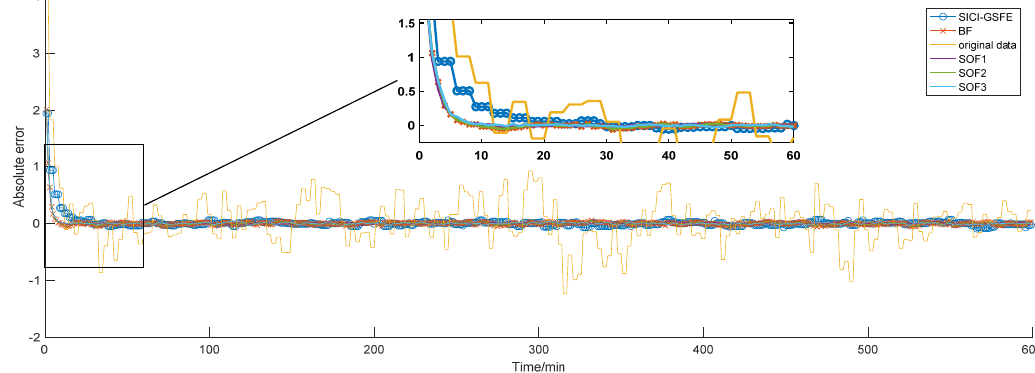
Figure 12. Simulation results of sequential analysis and inverse covariance intersection ‐ global state fusion estimation (SICI ‐ GSFE) algorithm.